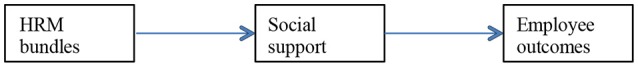
Conceptual model.